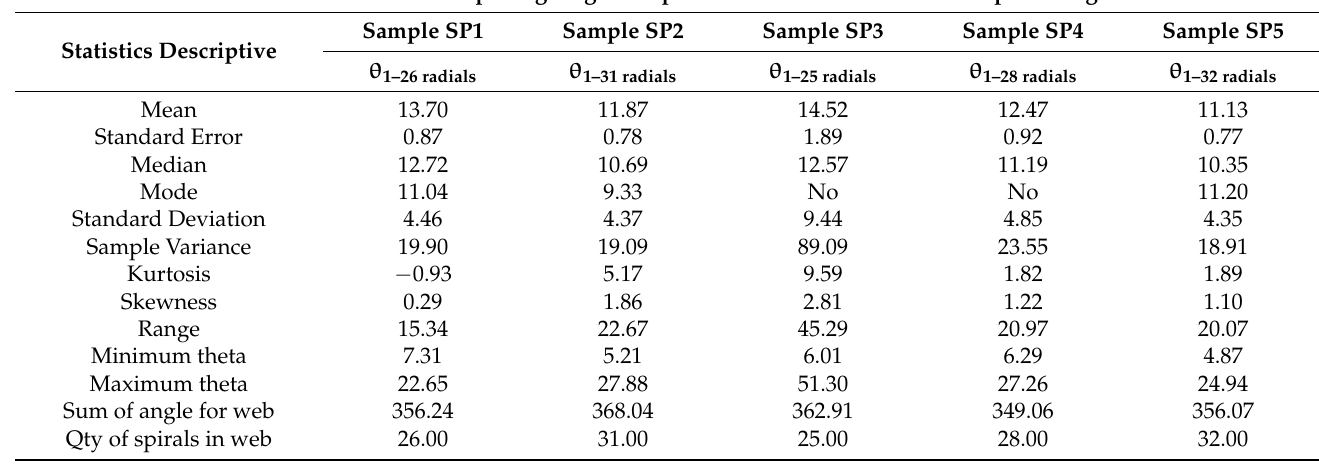
Figure 6. ( a ) Unmeasured image ( b ) measured image of SP5.